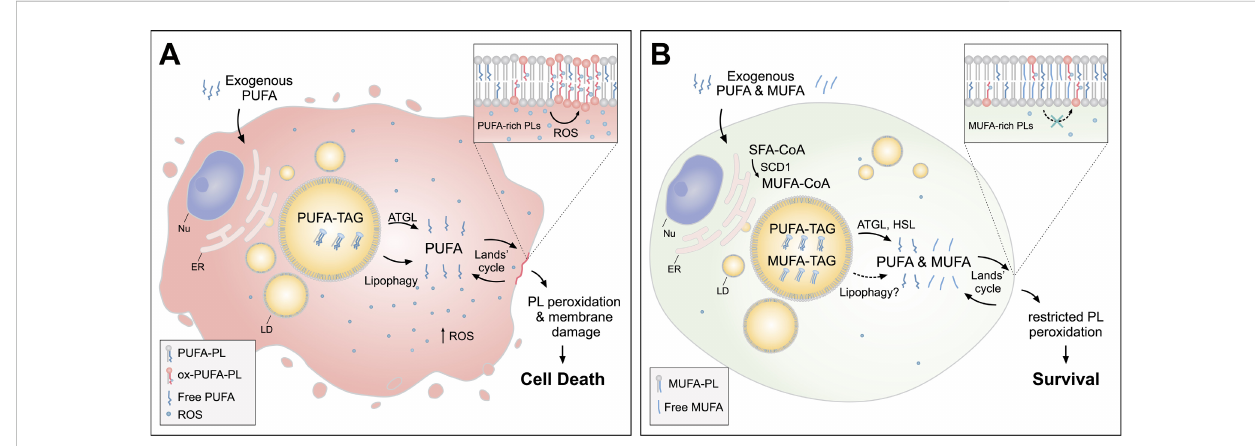
FIGURE 3 Lipiddroplets(LDs)releaseMUFAstoprotectcellsfromlipidperoxidationandcelldeath. (A) IncellsloadedwithexogenousPUFAs,thebiogenesisof LDs enriched with PUFA-TAGs is increased. Under these conditions, lipolysis via ATGL and lipophagy mediate the transfer of PUFAs from LDs to membranephospholipids (PUFA-PLs),thereby increasinglipid peroxidationand oxidative stress,which can leadtocell death. (B) WhenMUFAsare added simultaneouslywithPUFAsorsynthesizedbythecell via SCD1,LDareenrichedinbothspecies.Inthiscase,lipolysis via ATGLandHSL(andlikelyalso lipophagy) liberate both MUFAs and PUFAs from LDs, feeding a more balanced FA mixture for phospholipid acyl chain remodeling pathways (the Lands ’ cycle), leading to a reduced abundance of oxidizable PUFAs in membranes and restricted lipid peroxidation. Cofactors and by-products are omitted. ATGL, adipose triglyceride lipase; ER, endoplasmic reticulum; HSL, hormone sensitive lipase; MUFA, monounsaturated fatty acid; Nu, nucleus; Ox, oxidized; PL, phospholipid; PUFA, polyunsaturated fatty acid; ROS, reactive oxygen species; SCD1, stearoyl-CoA desaturase 1; SFA, saturated fatty acid; TAG, triacylglycerol.